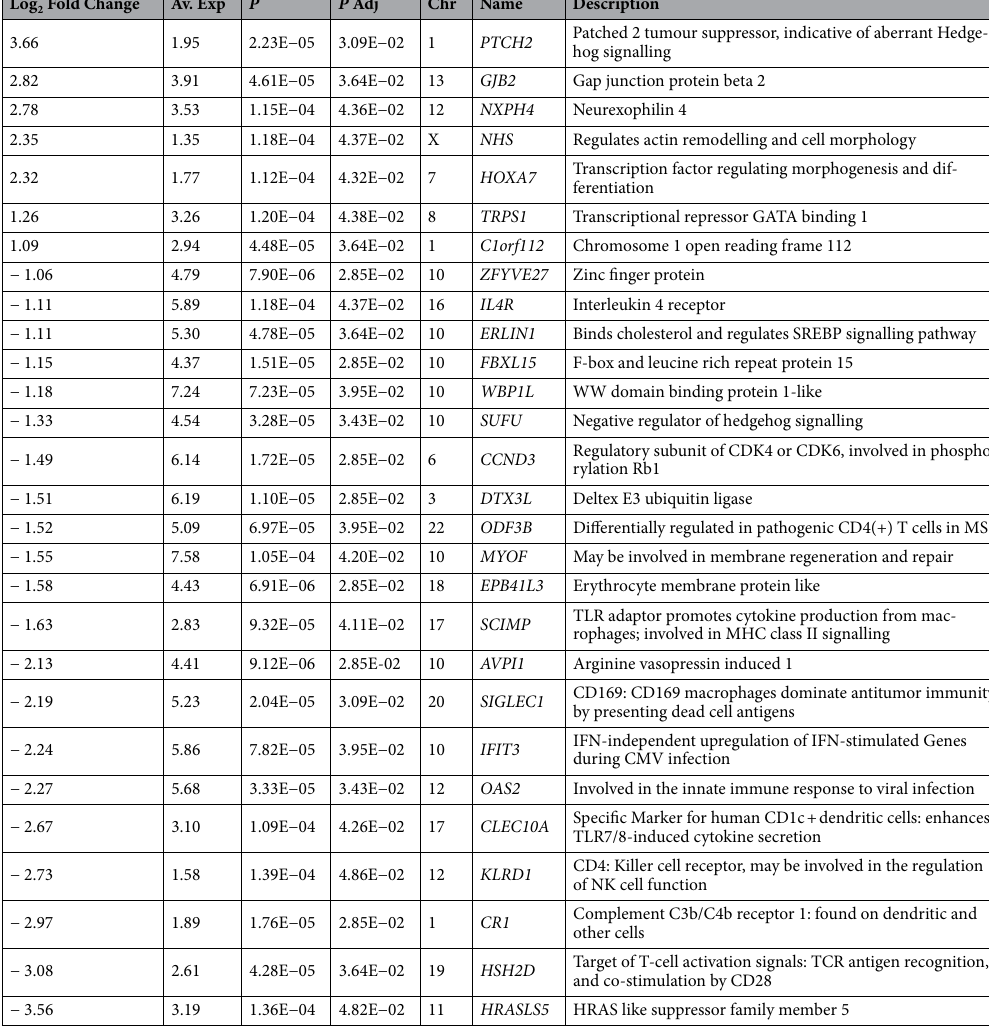
Table 1. Genes differentially regulated with SUFU locus deletions.